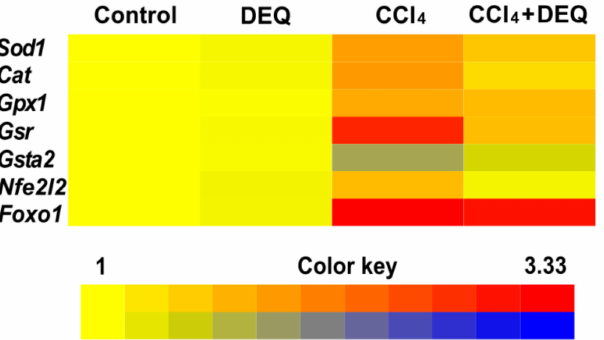
Figure 6. Analysis of hepatic S od1 , Cat , Gpx1 , Gsr , Gsta2 , Nfe2l2 , and Foxo1 mRNA levels by qPCR across the groups ( p < 0.05). Treatment with DEQ reduced CCl4-induced elevation of gene expression (S od1 , Cat , Gpx1 , Gsr, and Nfe2l2 ) in the liver of rats. Data are depicted in the heat map view in logarithmic scale.